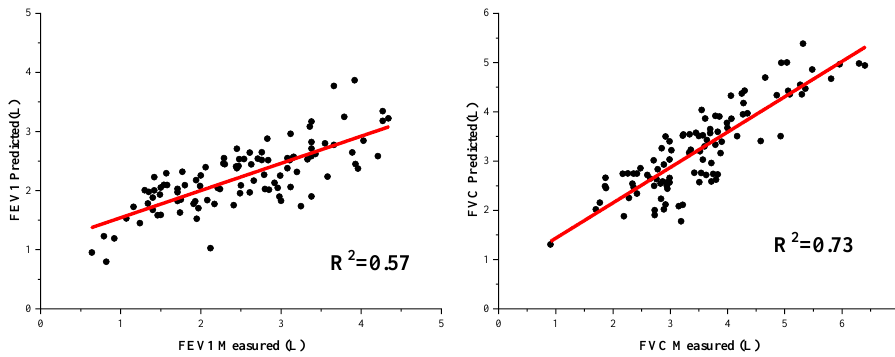
Figure 10. The fitting curves of the deep learning results.